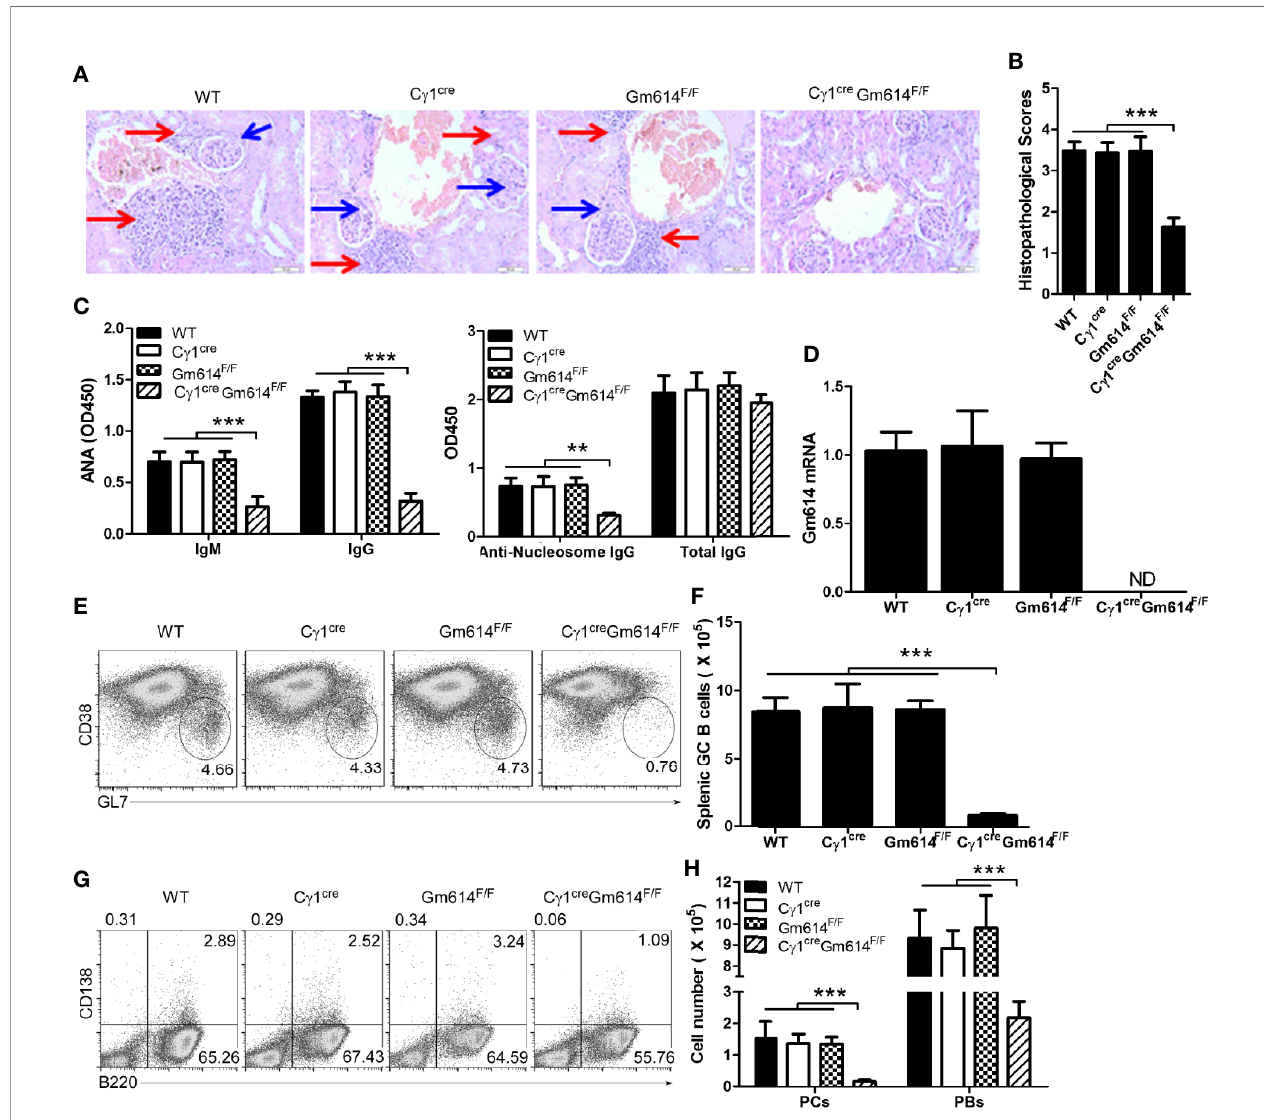
FIGURE 2 | Gm614 knocked-out (KO) in GC B cells (Gm614 cKO) mitigated symptoms in pristane-induced lupus. Nine-week-old WT, C g 1 cre (C g 1-cre), Gm614 F/F (Gm614 fl / fl ), and C g 1 cre Gm614 F/F (Gm614 cKO) mice were i.p. injected with 0.5 ml pristane and analyzed after 6 months. (A) Gm614 cKO reduced in fi ltrated in fl ammatory cells in the kidney of pristane-induced lupus. H&E-stained sections of the kidney. Scale bars, 50 µM. Blue arrows show glomeruli; red arrows show in fi ltrated in fl ammatory cells that appeared in the surrounding interstitial vasculature. (B) Gm614 cKO reduced histopathological scores of kidney. Histopathological scores were assessed based on loss of brush border, grading of tubular necrosis, tubular dilatation, and cast formation in 10 randomly chosen, non-overlapping fi elds. (C) Gm614 cKO reduced autoantibodies in pristane-induced lupus. Anti-nucleic antibodies (ANA) IgM and IgG, anti-nucleosome IgG, and total IgG were determined in the sera using ELISA assay. (D) Gm614 was depleted in Gm614 cKO mice. Splenic CD19 + B220 + CD38 lo GL7 hi GC B cells were sorted by FACS and subject to qPCR. (E, F) Gm614 cKO reduced GC B cells in pristane-induced lupus. On gated of CD19 + B220 + B cells, CD38 lo GL7 hi GC B cells were analyzed by FACS. The percentages (E) and absolute numbers (F) of splenic GC B cells are shown. (G, H) Gm614 cKO reduced PBs and PCs in pristane-induced lupus. The percentages (G) and absolute numbers (H) of splenic CD138 + B220 + PBs and CD138 - B220 + PCs cells are shown. (A – H) Data represent three independent experiments, with six samples per group per experiment. (B, D, F) One-Way and (C, H) Two-Way ANOVA was followed by Bonferroni post-tests, Error bars, s.e.m., ***p <